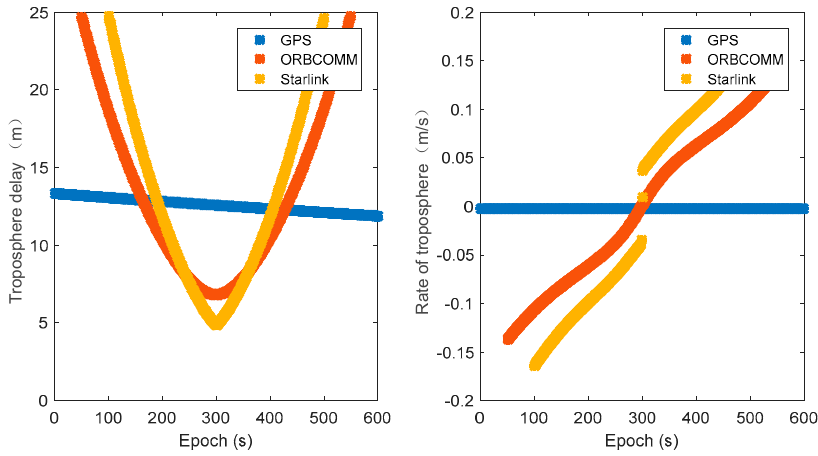
Figure 3. Tropospheric delay of GPS, Starlink ( left panel ) and Orbcomm Tropospheric change rate of GPS, Starlink, Orbcomm ( right panel ).